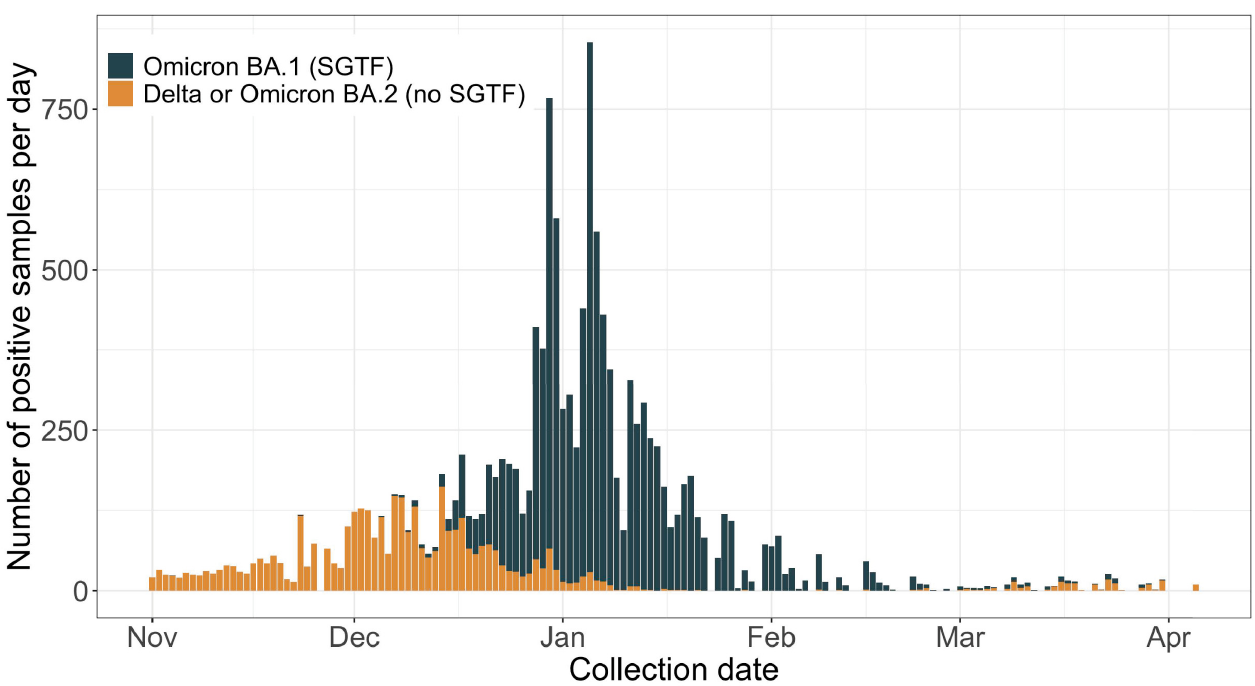
Fig 1. Daily Omicron lineage BA.1 (SGTF) and other variant (non-SGTF) SARS-CoV-2 infections identified during TaqPath testing at the YNHH between November 1, 2021 and April 30, 2022. TaqPath COVID-19 (Thermo Fisher Scientific) confirmed SARS-CoV-2 infections among vaccine-eligible individuals AU : AbbreviationlistshavebeencompiledforthoseusedinFigs 1 (cid:0) 3 : Pleaseverifythatallentriesarecorrect : . Infections were classified as Omicron (lineage BA.1) based on presence of SGTF. COVID-19, Coronavirus Disease 2019; SARS-CoV-2, Severe Acute Respiratory Syndrome Coronavirus 2; SGTF, S-gene target failure; YNHH, Yale New Haven Health System.